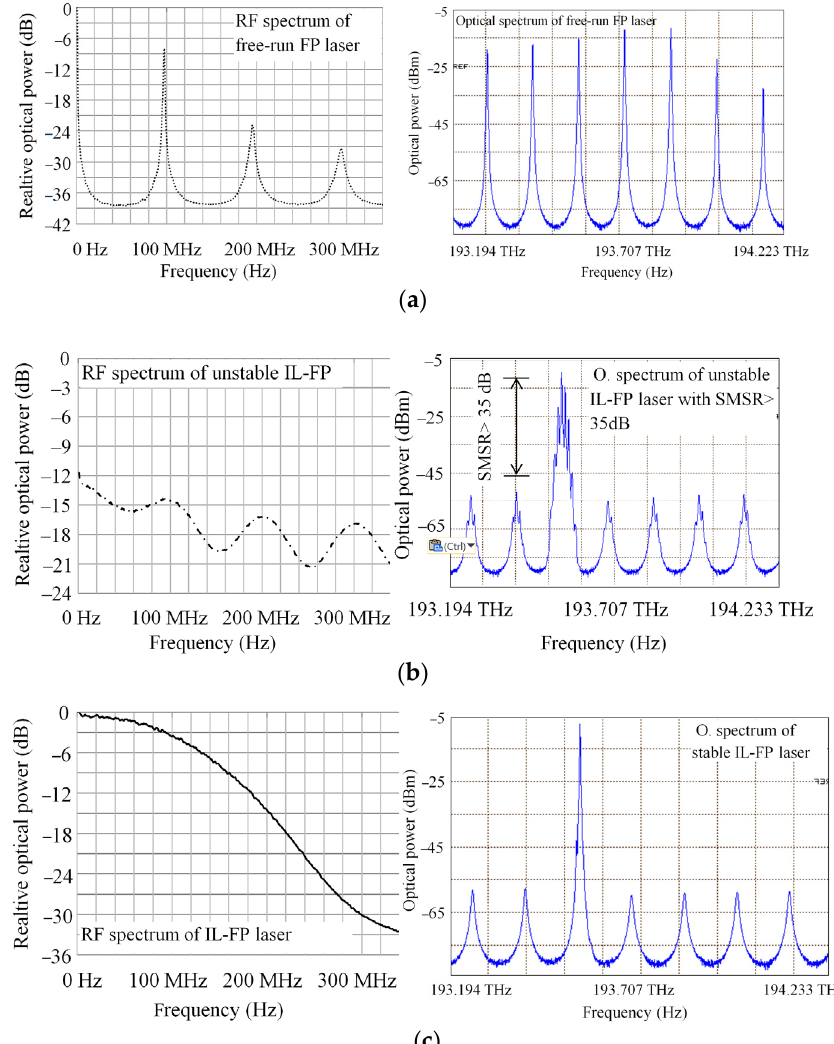
Figure 9. Experimental results for positive frequency detuning. Figure 9. ( a – c ) Experimental results for positive frequency